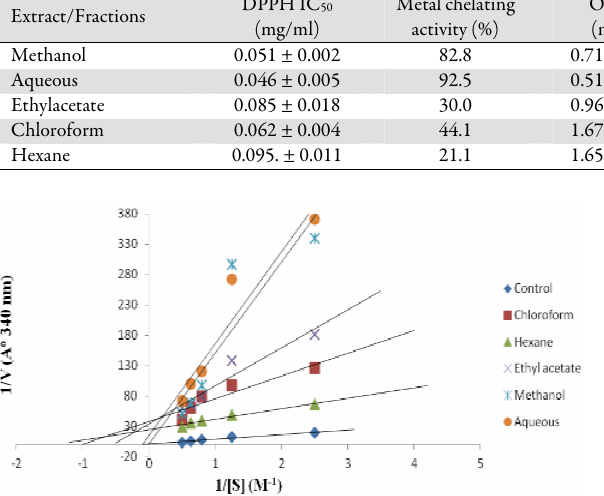
Table 5. Free radical scavenging activity of extract and fractions of C. odorata leaves Extract/Fractions